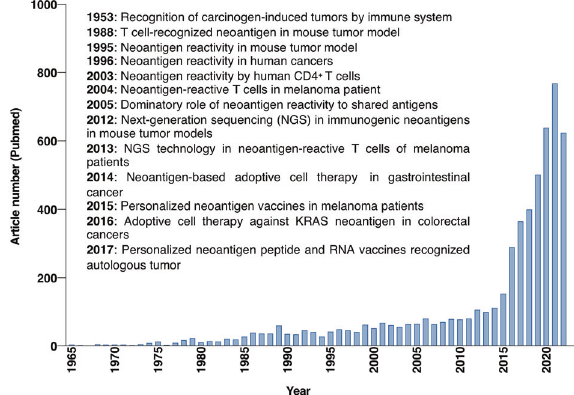
Fig. 1 Historical overview of tumor-speci fi c neoantigens. Based on keyword searches in the PubMed database using the terms "neoantigen" or "neoepitope", the number of articles from 1965 to 2022 is displayed in the column